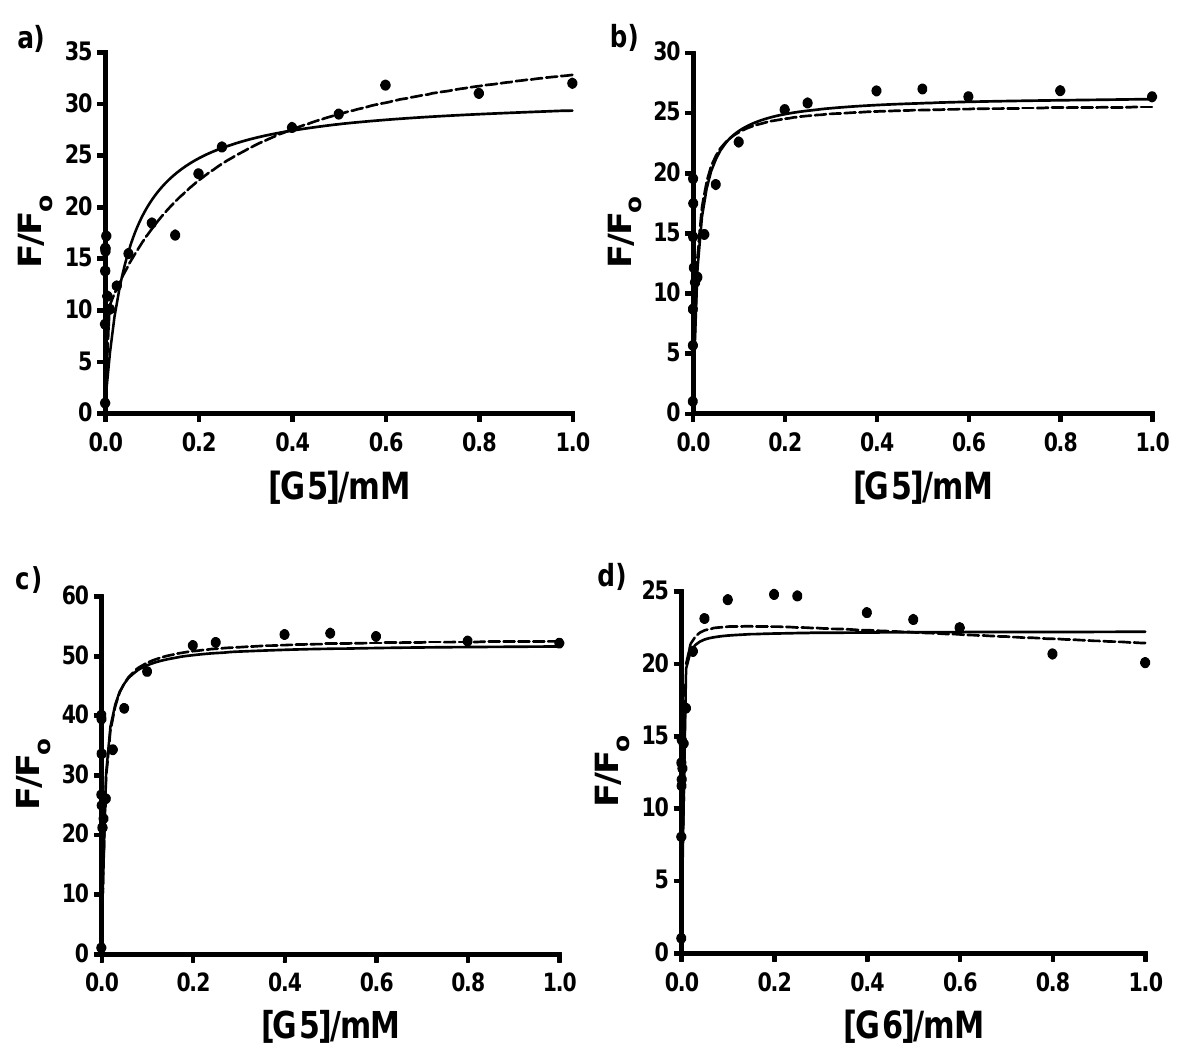
Figure 5. Averaged host fluorescence titration plots for 4 × 10 -5 M a) 1,8-ANS, b) 2,6-ANS and c) 2,6-TNS as a function of G5 and d) 2,6-ANS as a function of G6 PAMAM dendrimer concentration, with the fits to the 1:1 (  ) and 2:1 (- - -) models also